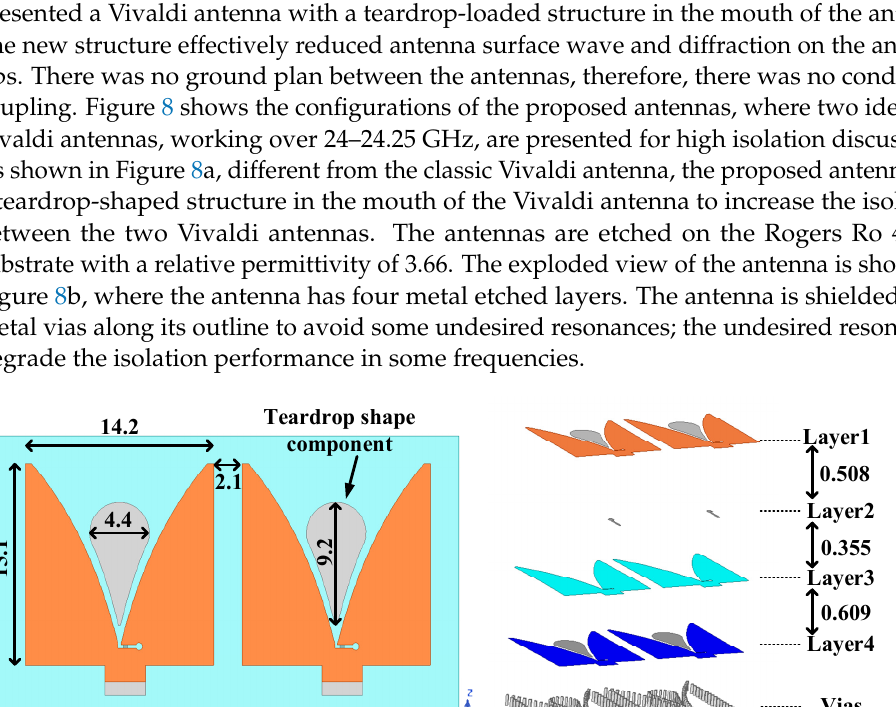
10 of 14 Table 2. Comparison of isolation optimization of different methods. Reference